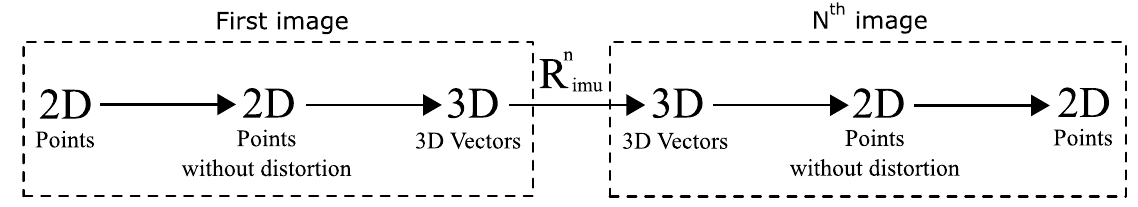
Figure 8. The various steps required to obtain the approximate initial homologous point in another image. R n is the 3D rotation obtained by IMU measurements. imu